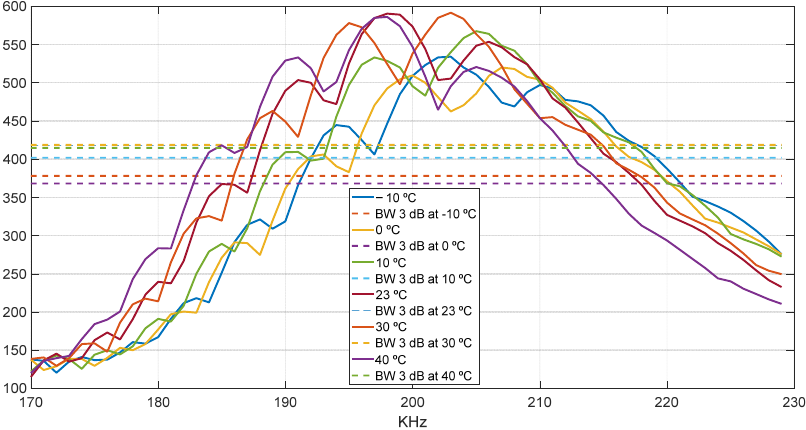
Figure 18. Frequency response at different temperatures.